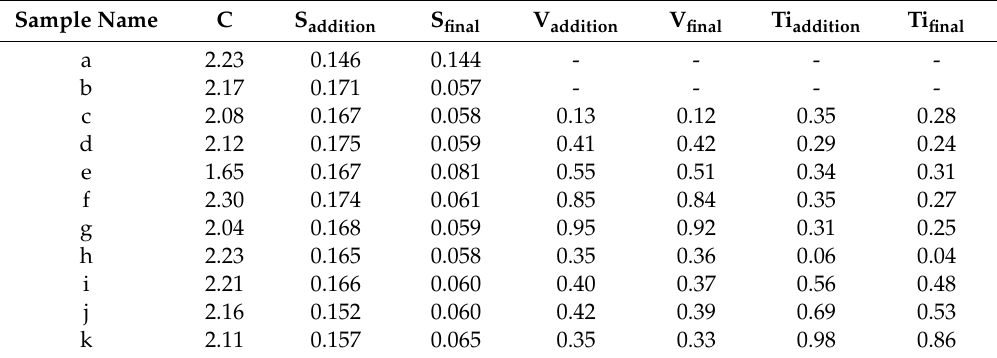
Table 4. Compositions of elements in liquid iron (wt. %).